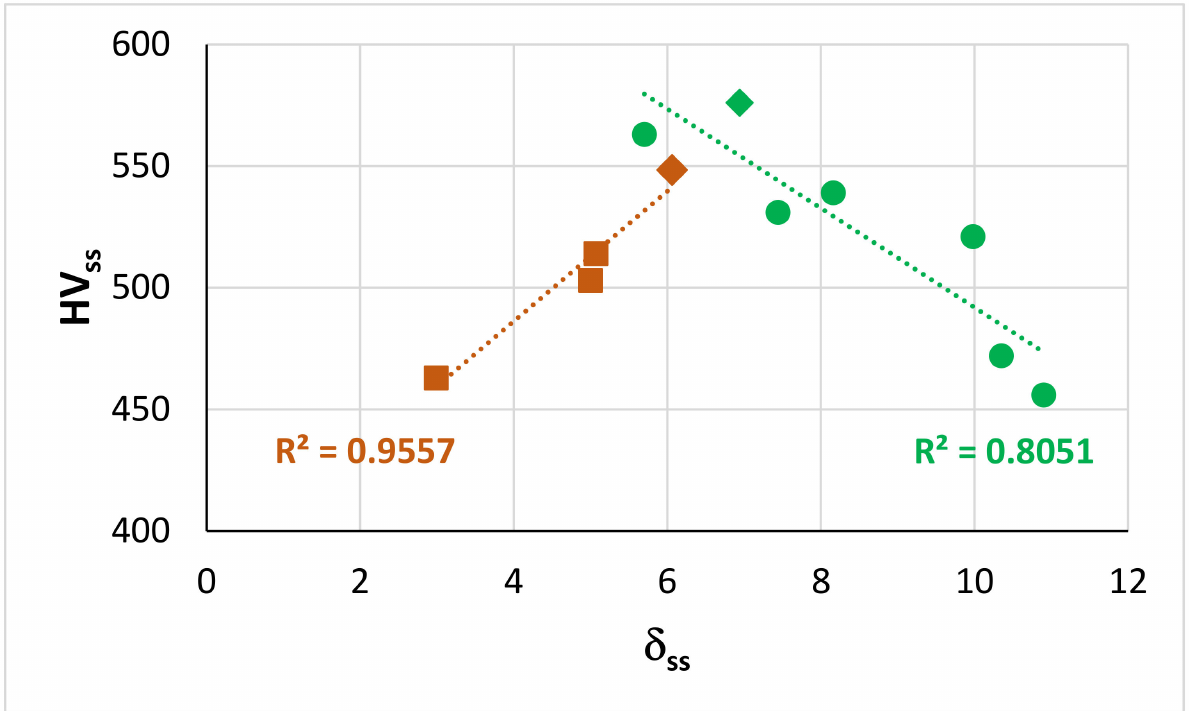
Figure 4. Relationships between HV ss versus δ ss for as cast Nb-24Ti-18Si-based alloys (KZ series alloys (see Appendix A, brown data) [25,26] and for as cast Nb-24Ti-18Si-based alloys with B and RM (=Mo,Ta) addition (green data) [12,13]. The diamond data points correspond to alloys with Ta addition. For the data indicated with squares and diamonds R 2 = 0.970.